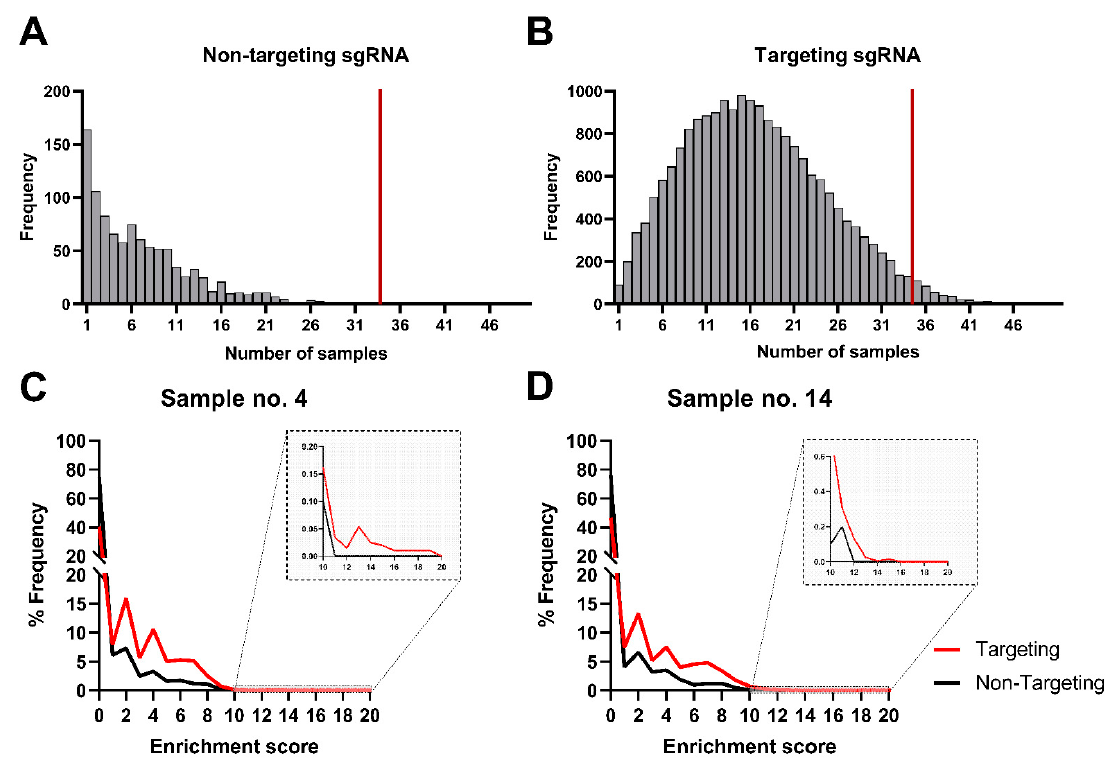
Figure 2. sgRNA frequency trends in non-targeting controls and targeting sgRNAs. ( A , B ) histograms present the distribution of sgRNA elevated abundance frequency (y-axis) among 48 samples (x-axis) for both non-targeting control and targeting guides, respectively. ( A ) summarizes the number of samples for which we detected control gRNAs, not targeting the human genome. The height of each bar corresponds to the number of non-targeting gRNAs that were detected. ( B ) A similar summary for gRNA targeting the genome is presented. The height of each bar corresponds to the number of gRNAs detected; however, the distribution differs. Panels ( C ) and ( D ) show density plots of normalized abundances (enrichment score) for two (from sixteen) representative samples for targeted (red) and non-targeted (black) sgRNA, respectively, which validates the performance of our normalization. The graphs from all 16 samples are presented in Supplementary Figure